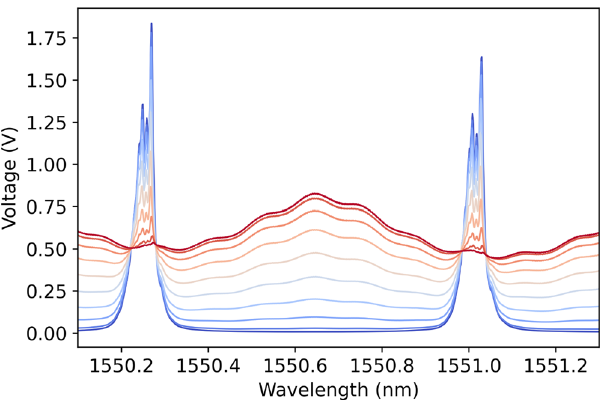
Fig. 4 Measured transmittance of the meta-etalon versus wavelength of the incident light. The different colors indicate nine different angles of the linear polarized light between transverse electric (electric fi eld parallel to structure, blue color, bottom line) and transverse magnetic polarized light (magnetic fi eld parallel to structure, red color, top line). This plot shows nine different polarization angles between transverse electric (electric fi eld parallel to structure, blue color) and transverse magnetic polarized light (electric fi eld parallel to structure, red color).